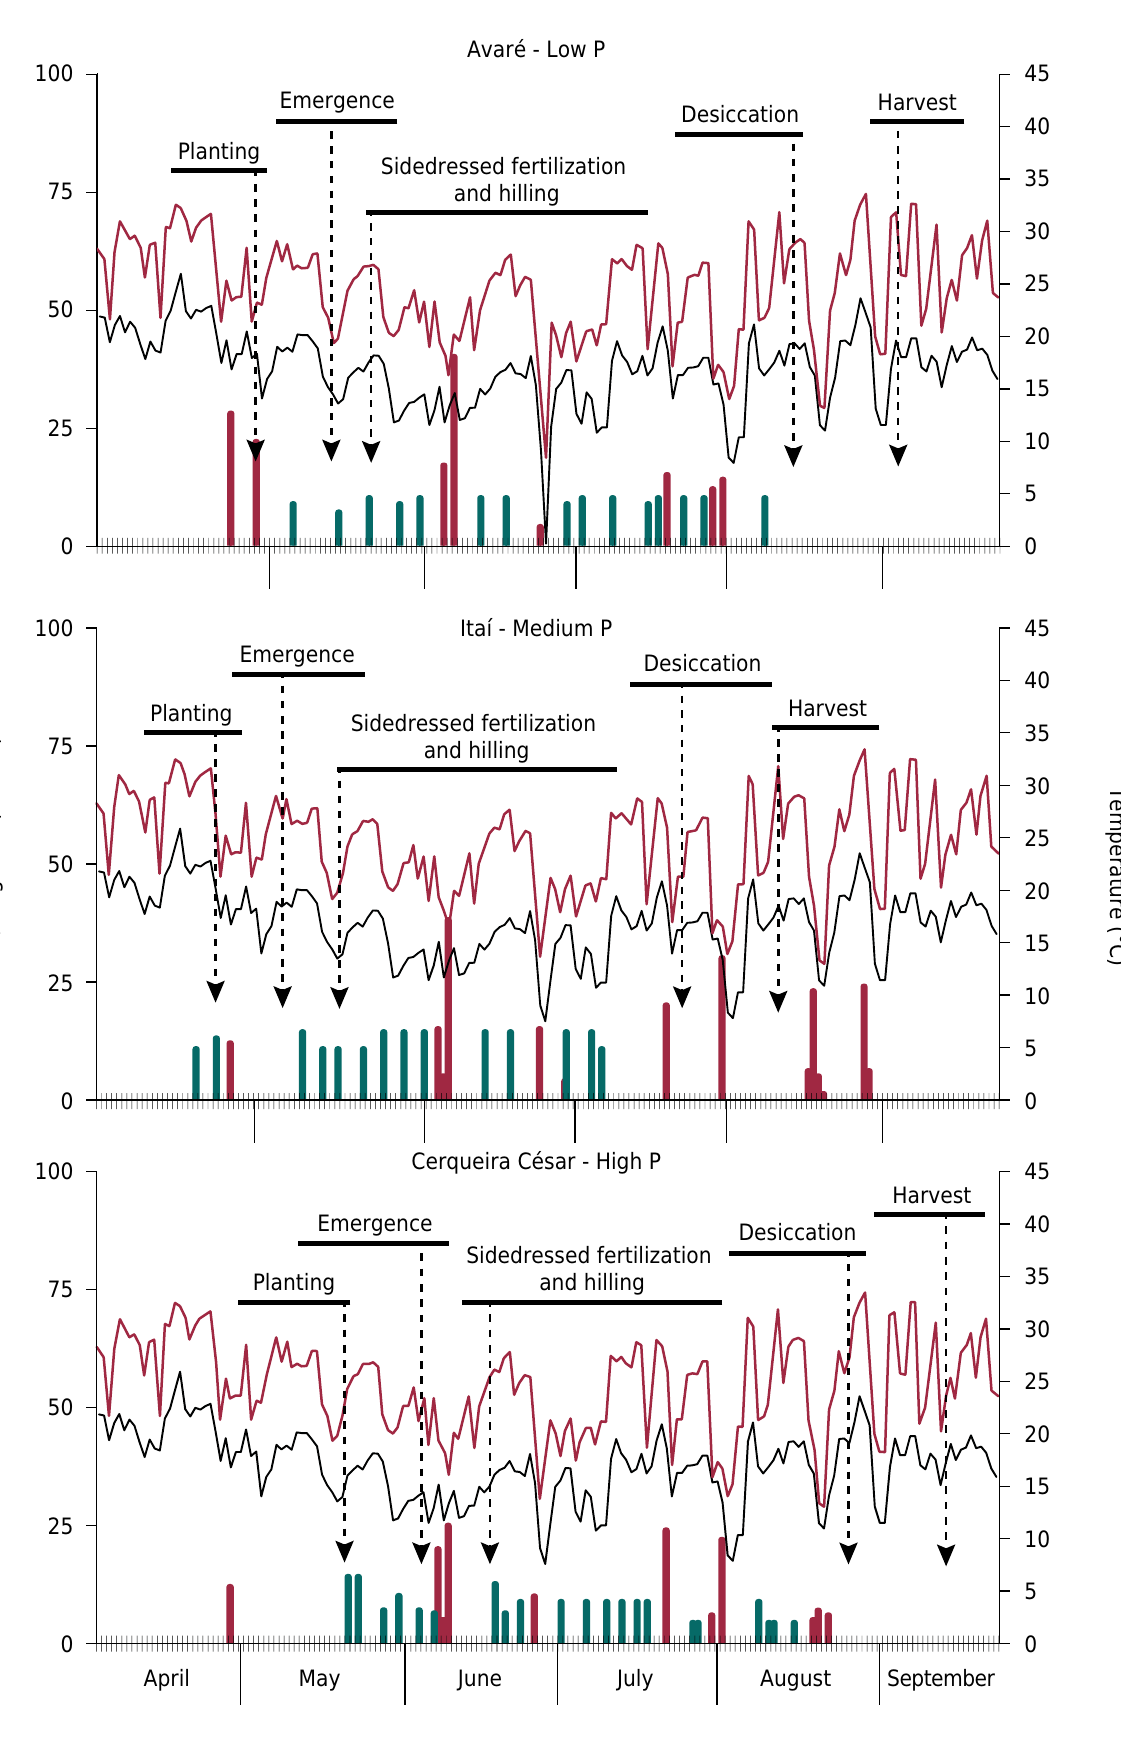
Figure 1. Daily rainfall ( ), irrigation ( ), and maximum ( ) and minimum ( ) temperatures in the three experimental areas with low, medium, and high soil P availability, from April to September